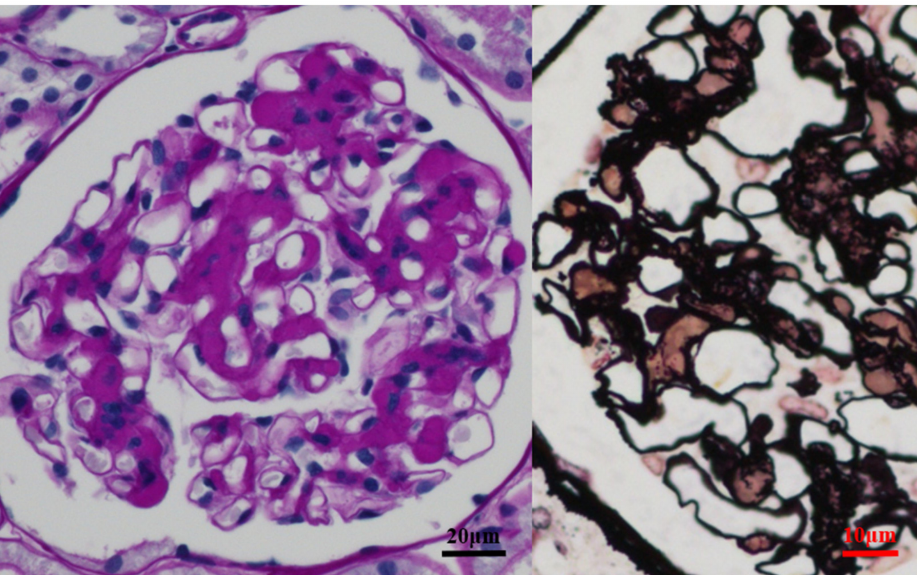
Figure 1. Mesangial expansion in immunoglobulin A nephropathy (IgAN) with massive IgA deposi- tion. In cases with massive IgA deposition, pronounced hemispherical deposits are often observed (left PAS). Regardless of the extent of mesangium proliferation in response to IgA deposition, it is located in the extra-capillary area (brown) and did not occlude the glomerular vascular cavity (right,